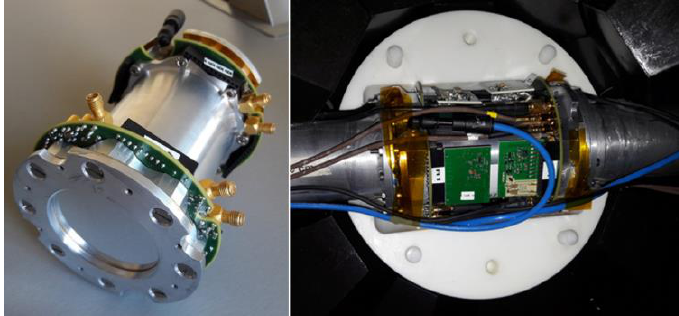
Fig. 5. The fission chamber: prototype in the lab (left panel); fully operational chamber mounted inside the white absorber in the TAC (right